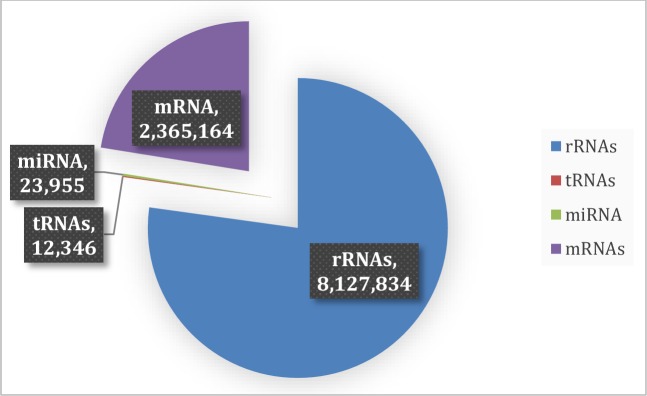
Composition of RNA reads from the H. contortus adult ES small RNA library mapped to H. contortus RNA sequences.Numbers indicate number of unique reads for each RNA category.